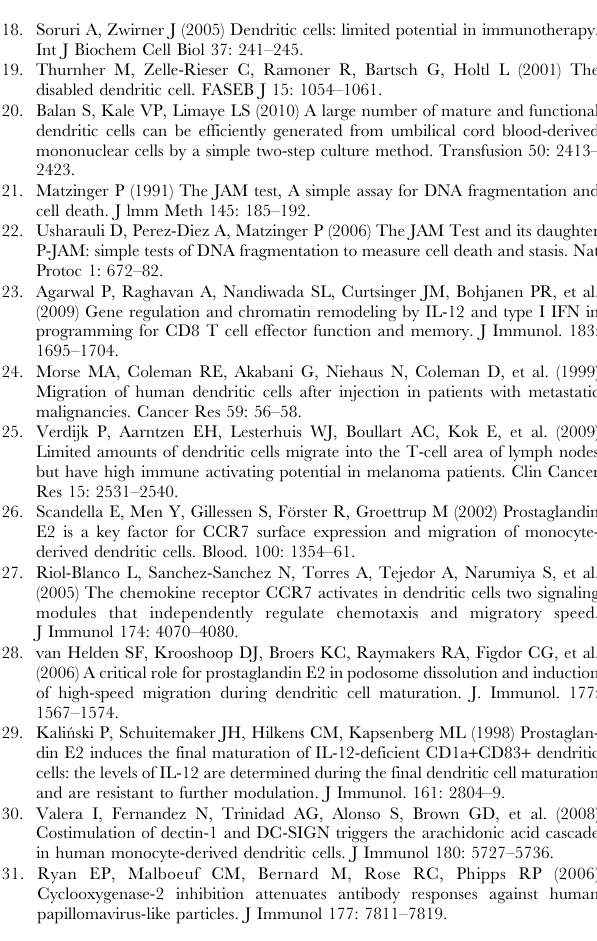
Figure S1 Flow chart depicting the design of the experiment. Figure S2 Sequence of four primers used in the study.